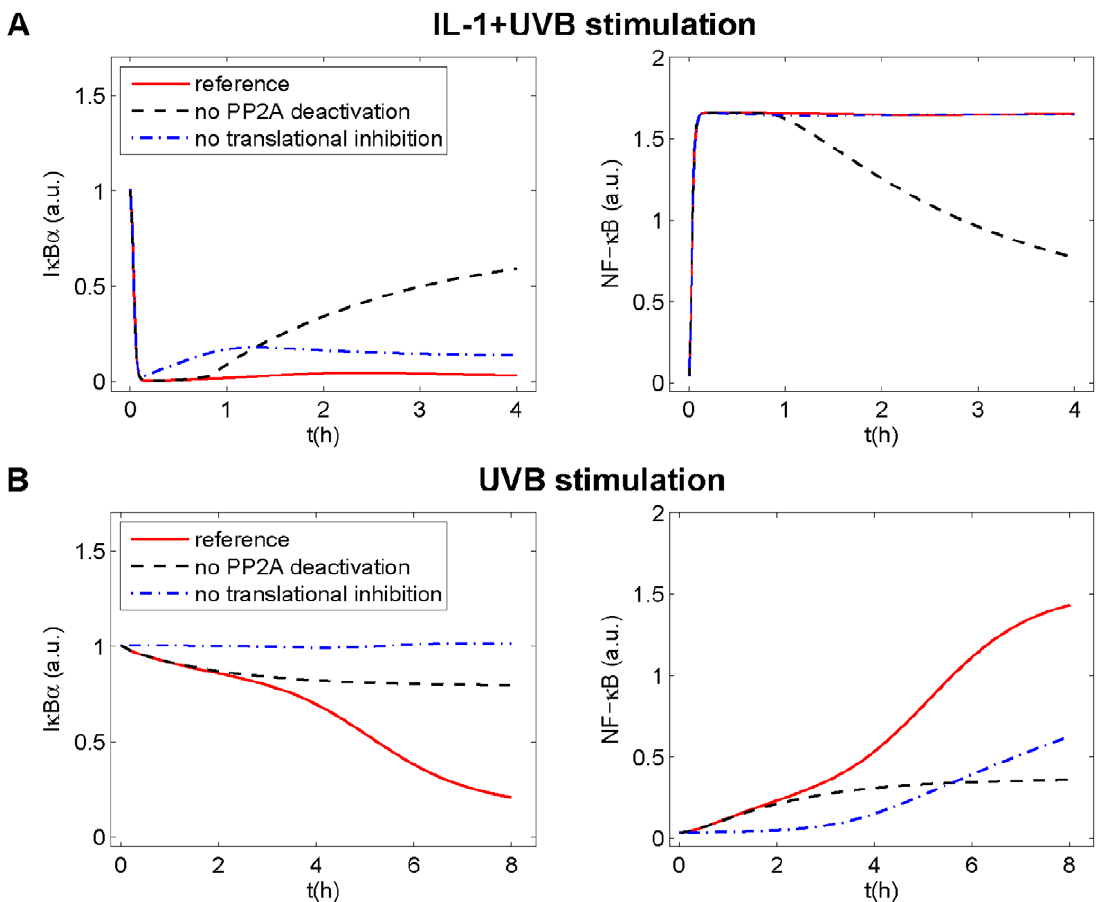
Figure 5. Relevance of UVB-induced translational inhibition and PP2Ac deactivation for I k B a and NF- k B upon UVB + / 2 IL-1 stimulation. Knocking out the processes of UVB-induced translational inhibition or PP2Ac deactivation in silico , their importance for I k B a and NF- k B in model M Ref is determined. (A) Upon IL-1 + UVB stimulation, lack of PP2Ac deactivation leads to recurrence of I k B a and decrease of NF- k B activity, while lack of translational inhibition only leads to a minor increase of the I k B a concentration. (B) Upon UVB stimulation, lack of PP2Ac deactivation leads to a modest decrease of I k B a concentration and to a modest increase of NF- k B activity, while lack of translational inhibition leads to a slow increase of NF- k B activity.